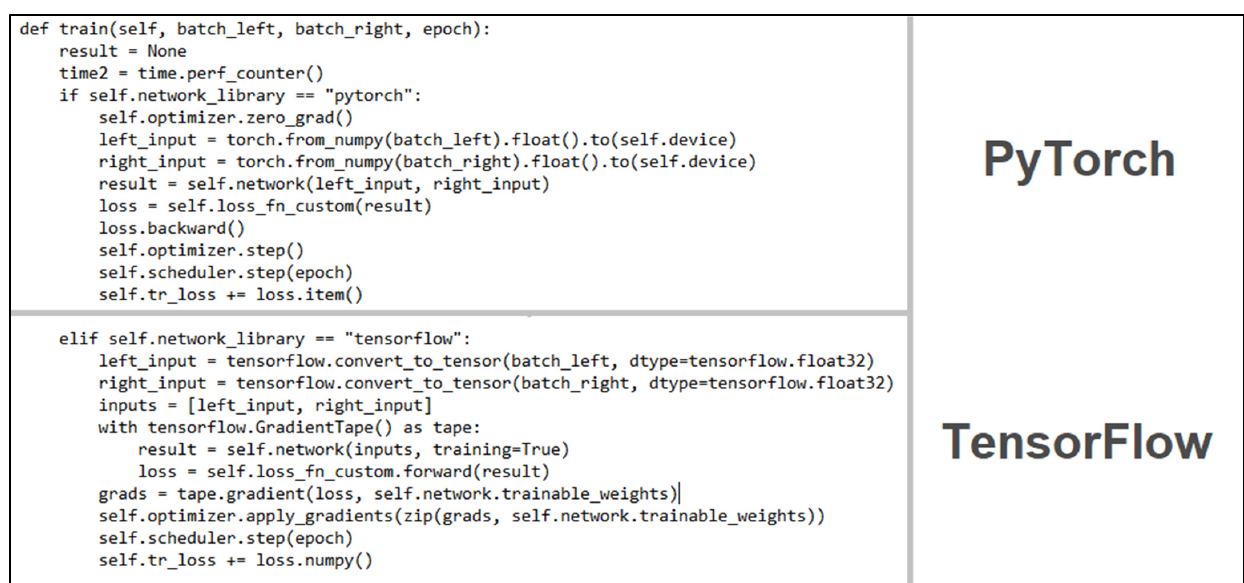
Figure 7. Loss function comparison.